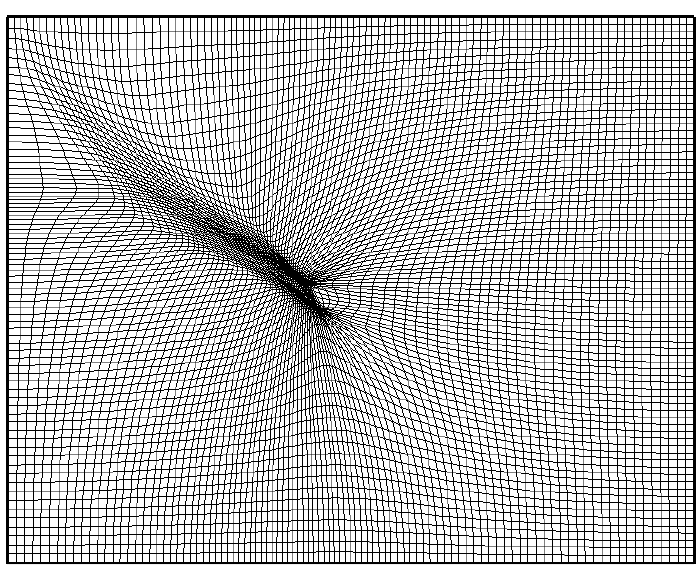
Figure 3. Adapted grid during a biomass burning plume simulation with AG-CMAQ.